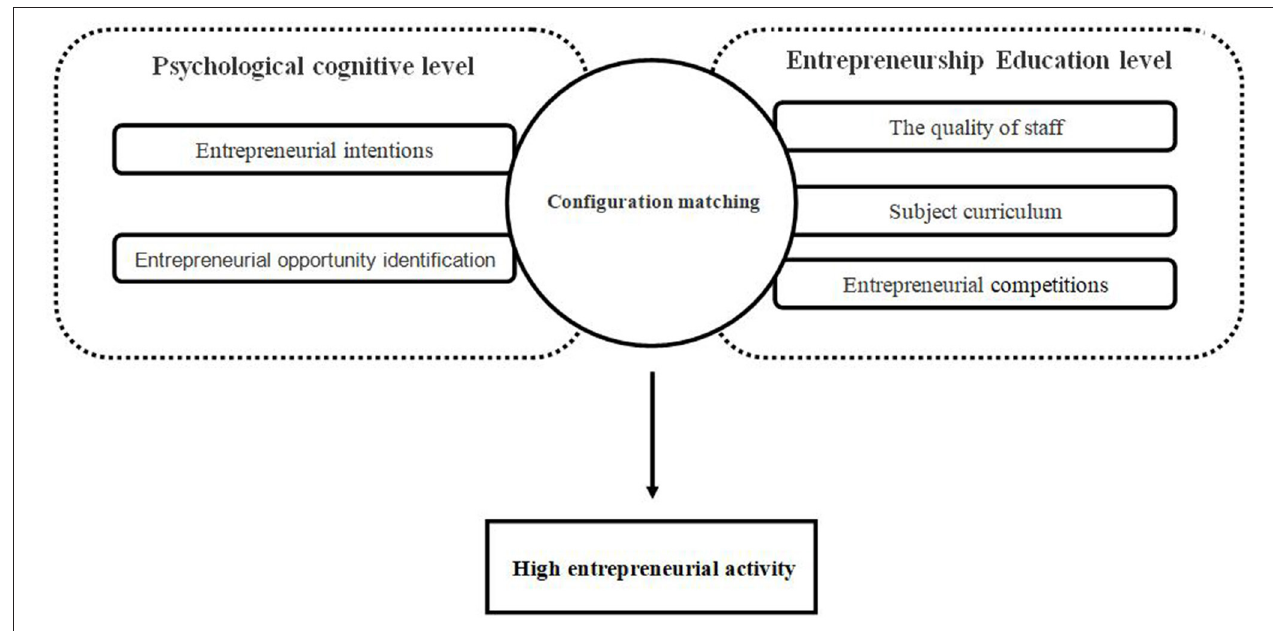
FIGURE 1 | Concept